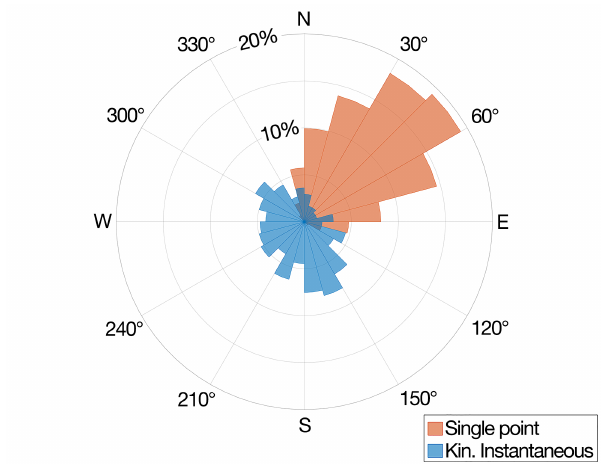
Figure 8. Histogram of the single-point and kinematic instantaneous error position